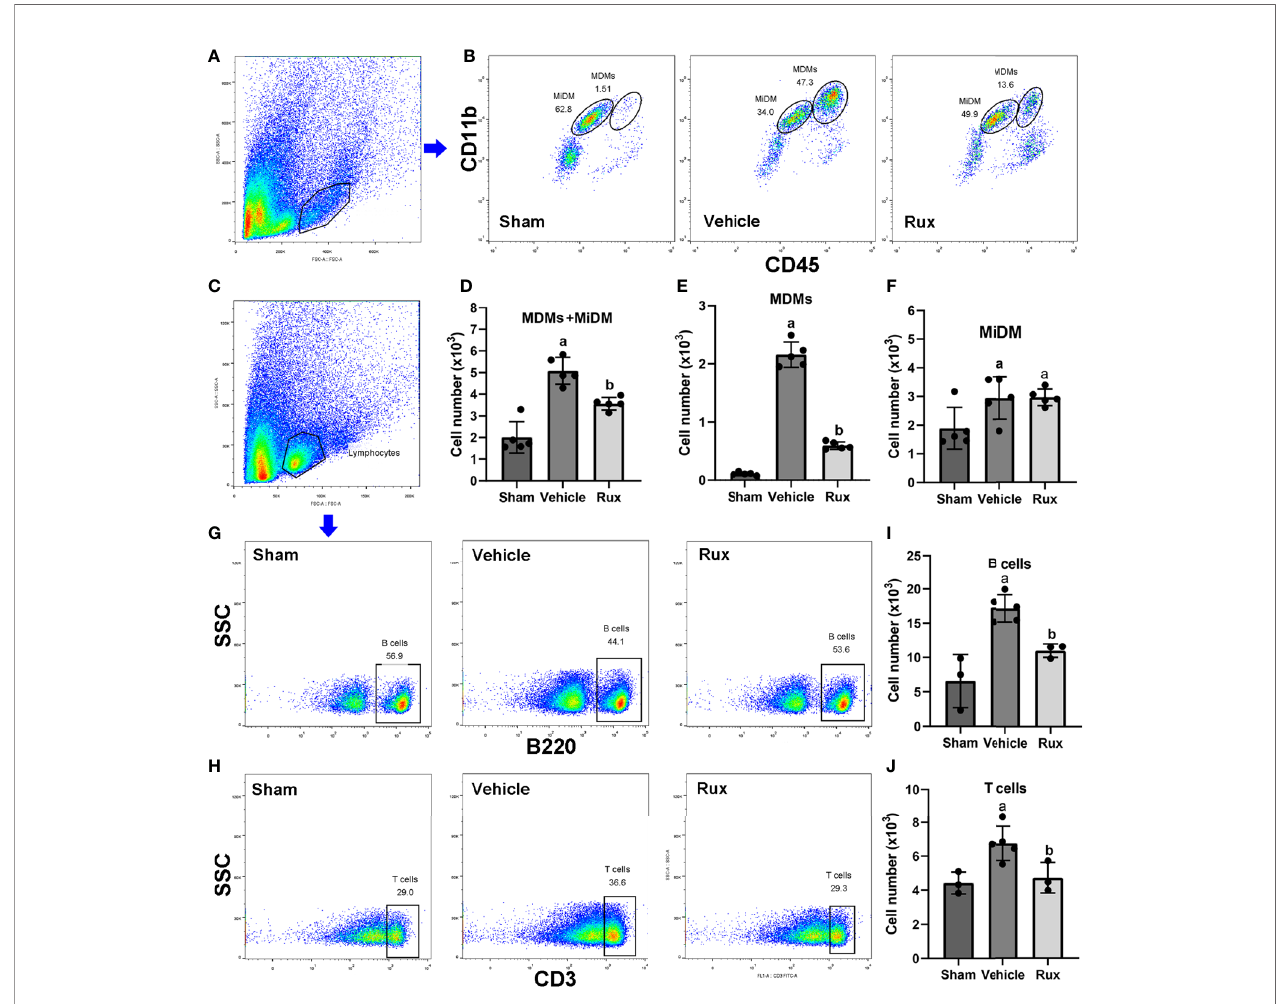
FIGURE 5 | Rux administration reduced the in fi ltrated macrophages, B, and T cells. (A, B) Gating strategy to identify CD45 inter CD11b + (MiDM) and CD45 high CD11b + (MDMs) cells. (D – F) Bar graphs showing the results for CD45 inter CD11b + (MiDM) and CD45 high CD11b + (MDMs) cells. (C, G, H) Gating strategies for identifying B220 + B cells, and CD3 + T cells. (I, J) Bar graphs showing the results for B lymphocytes and T lymphocytes. n = 3 to 5 per group. a P < 0.01 versus sham; b P < 0.01 versus